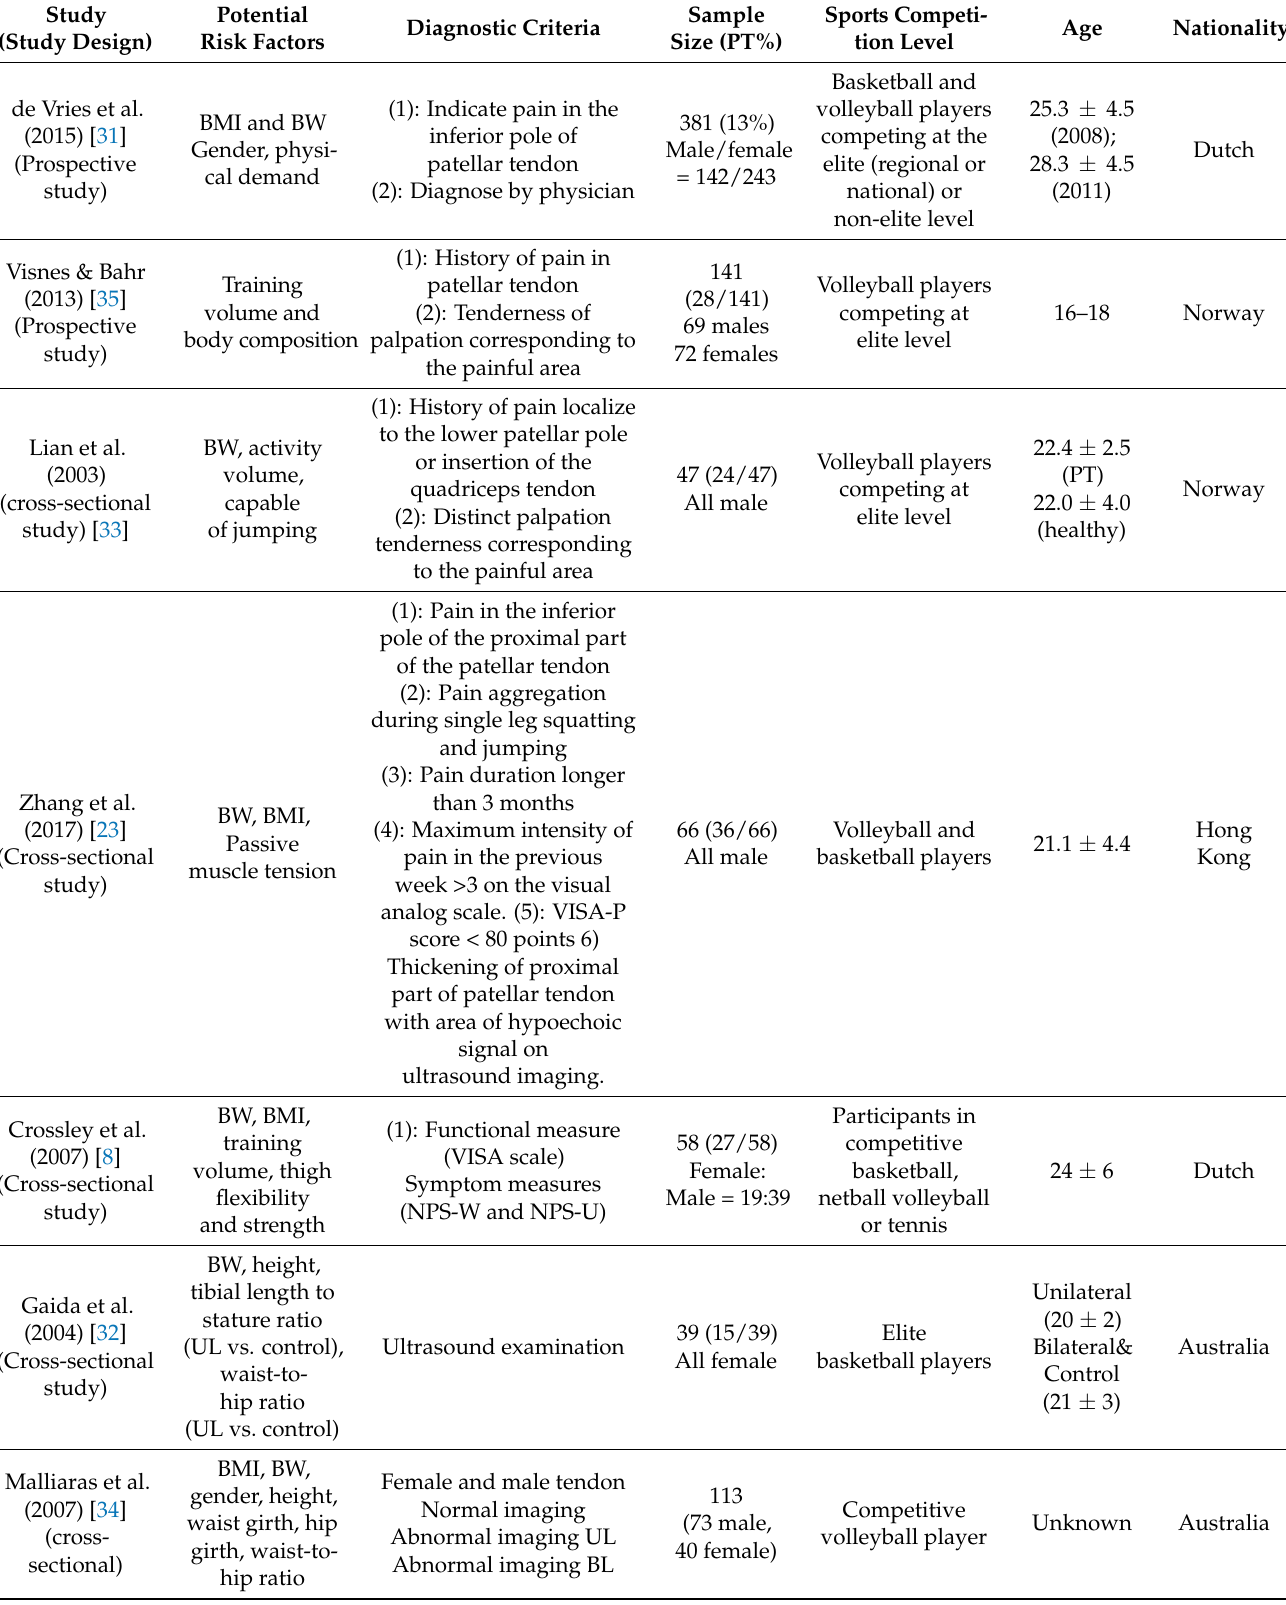
Table 1. Characteristics of the studies